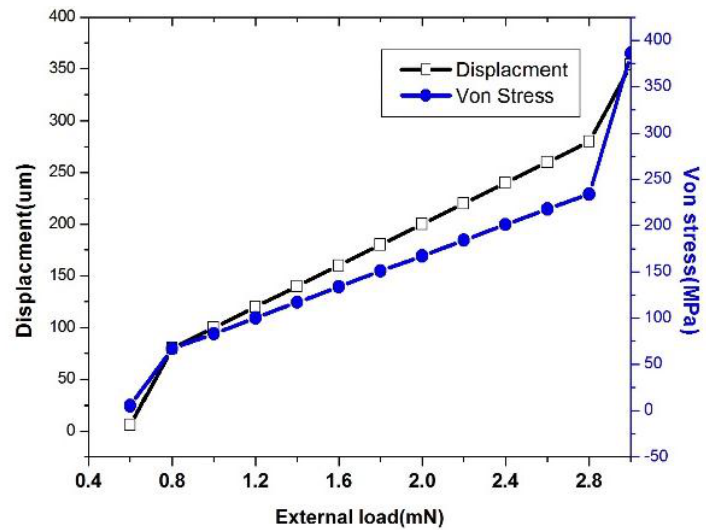
Figure 5. The displacement and Von stress under different external load.